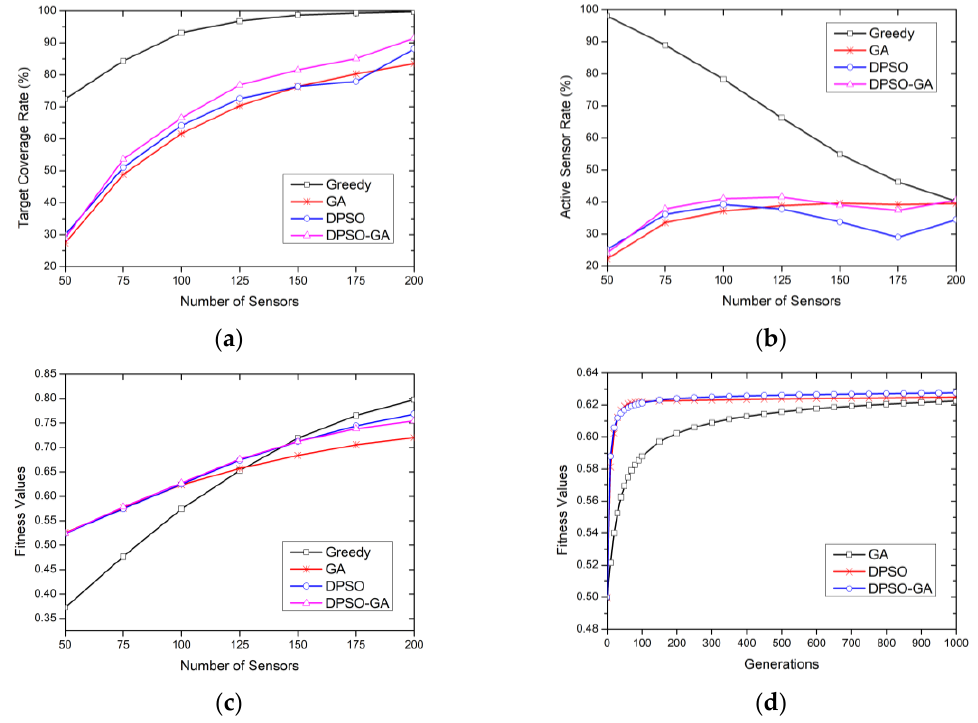
Figure 4. Effect of the number of sensors on the target coverage rate, active sensor rate, and fitness values for the greedy, GA, DPSO, and DPSO_GA algorithms. ( a ) Target coverage rate, ( b ) active sensor rate, ( c ) fitness values, and ( d ) fitness values versus the number of generations for GA, DPSO, and DPSO_GA.